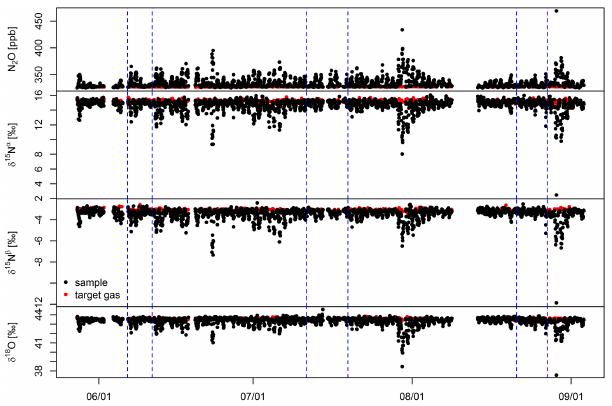
Figure 2. Target gas (red) and surface layer (black) N 2 O mole frac- tions (top) and δ values (three bottom panels) measured in the at- mospheric surface layer at 2.2m height during the field campaign. Each pair of vertical dashed blue lines indicates the management events mowing (first line) and fertilization (second